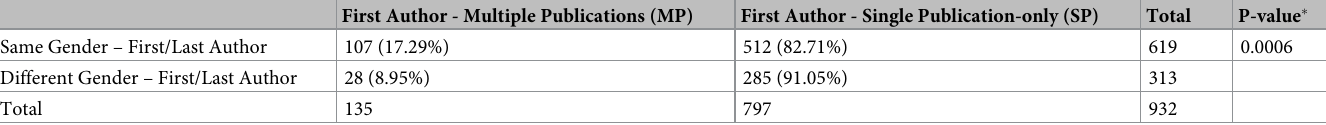
Table 10. Multiple publication rates based upon gender alignment between first/last significant